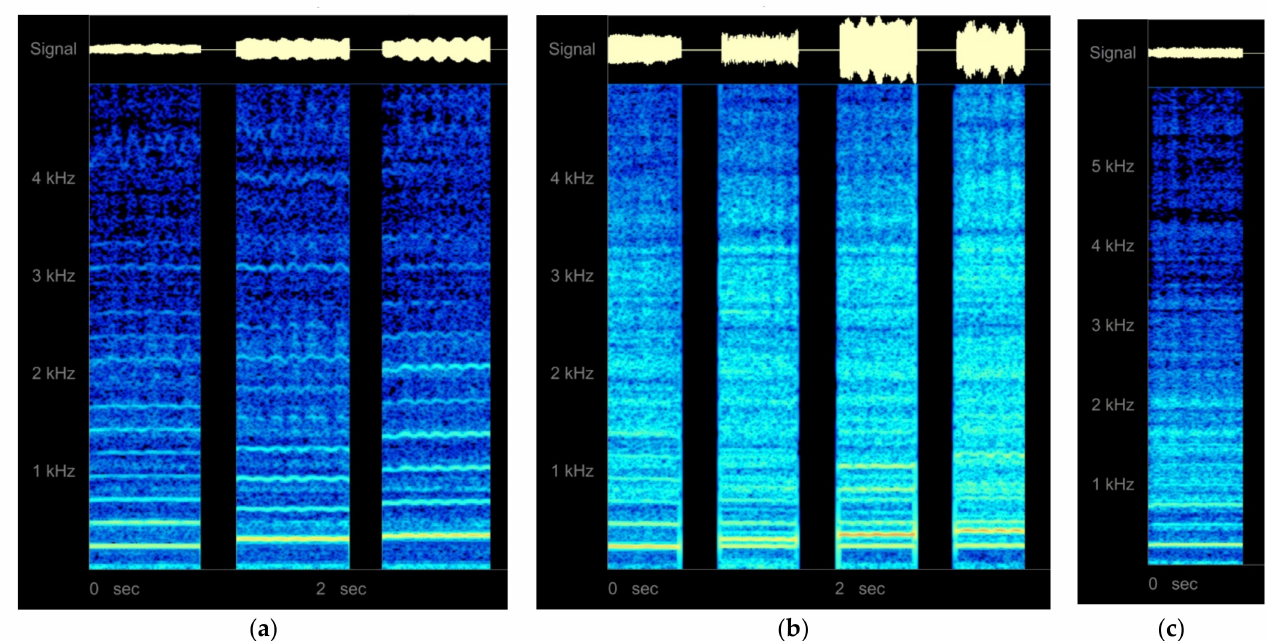
Figure 21. Spectrogram of quadruple flute, Zacuala Palace, Teotihuacan (MNA, Inv. 10-223540), low blowing pressure: ( a ) pipe A fingering combinations (left: A1–A3 stopped; centre: A1–A2 stopped; right: A1 stopped); ( b ) pipe B fingering combinations (from left to right: A1–A3 stopped; A1–A2 stopped; A1 stopped; A1–A3 open), pipe A has not been fully muted, as made visible by the lowest fundamental frequency in the combinations 2–4; ( c ) pipe C (Sample